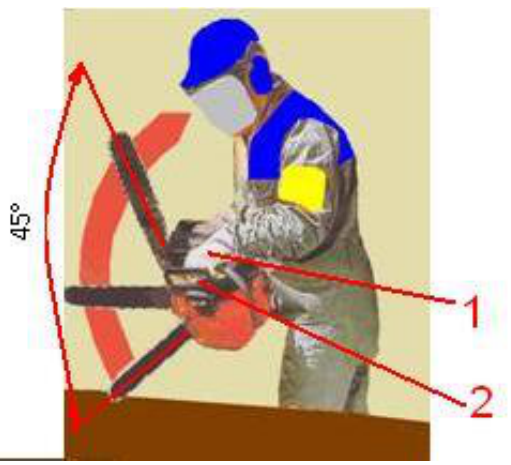
Figure 8. Chainsaw kickback. 1: operator’s hand holding front handle and moving front guard forward (activating the brake); 2: movable front guard; 45°: permissible kickback angle or saw chain stopping angle.